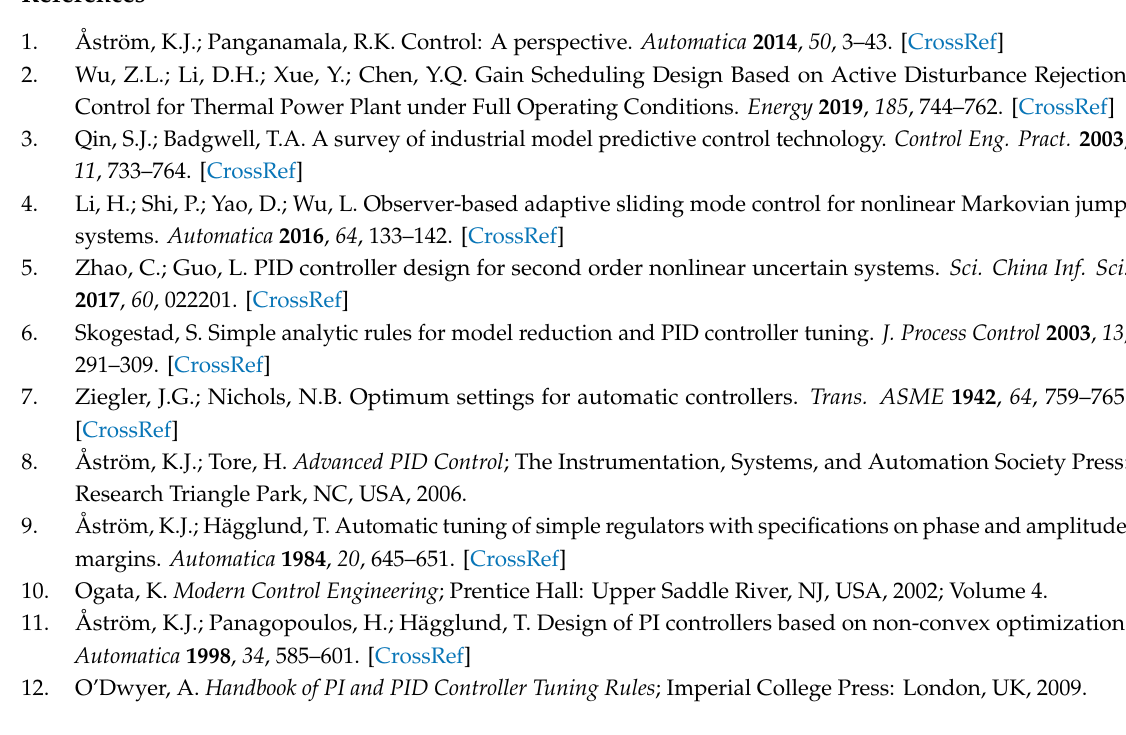
Figure A3. The control signal of tracking performance with different b and c .